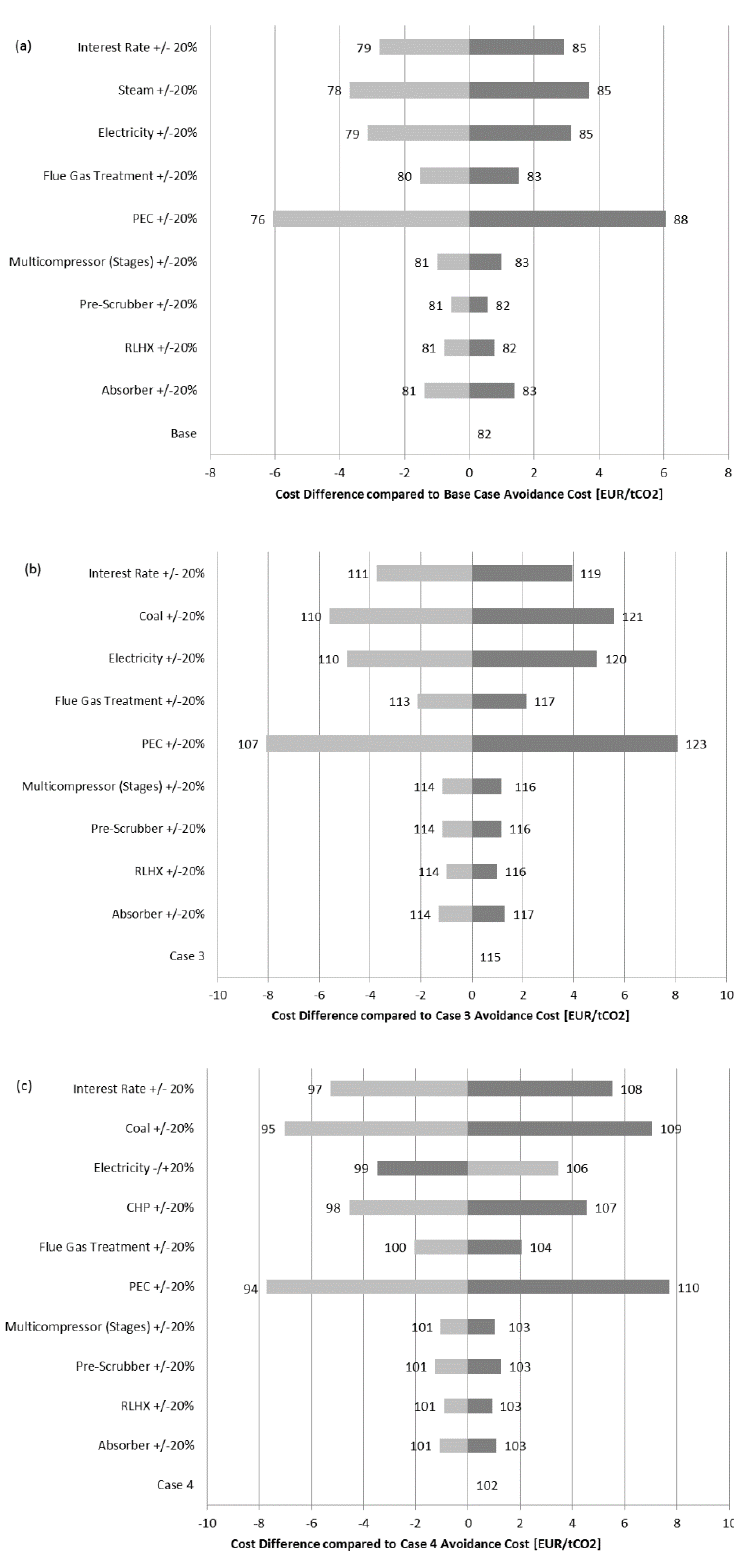
Figure 4. Sensitivity analysis of CO 2 avoidance costs for base case ( a ), case 3 ( b ), and case 4 ( c ).